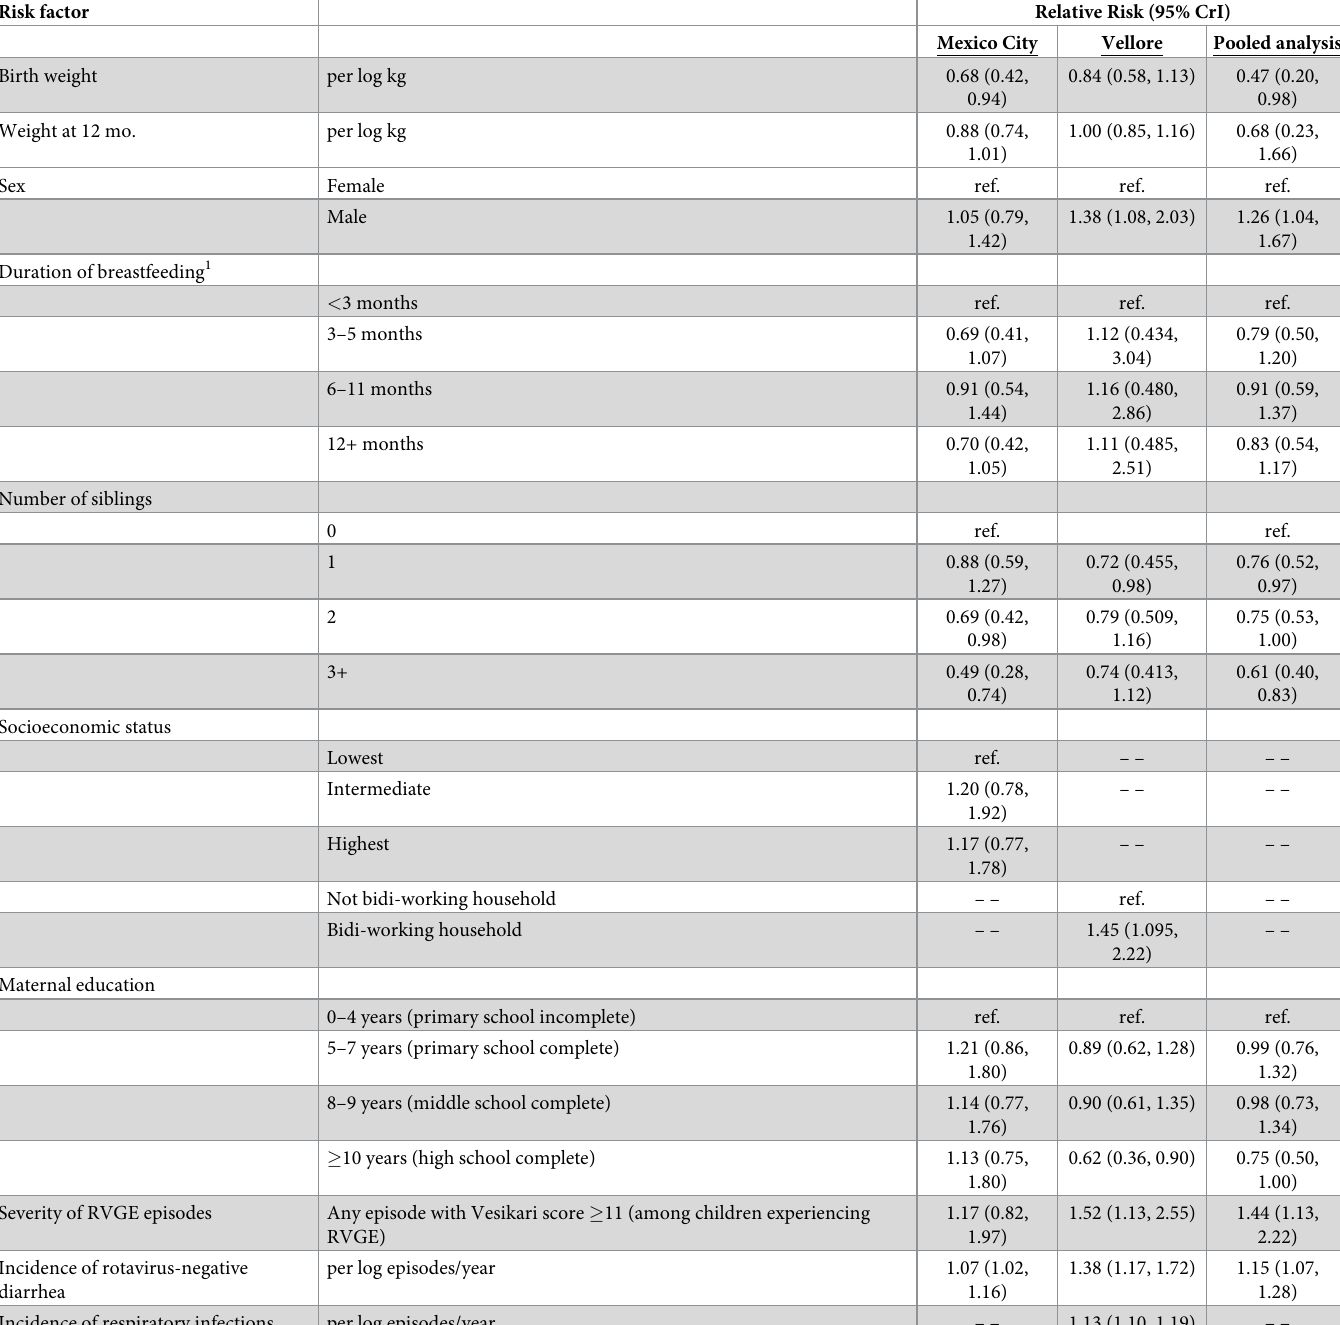
Table 3. Factors associated with belonging to the “high-risk”